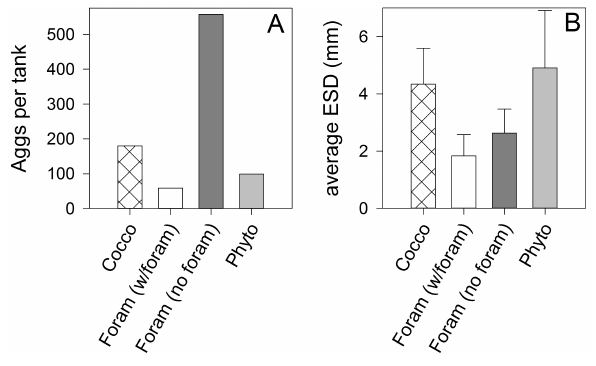
Fig. 1. Average (A) number and (B) equivalent spherical diame- ter (ESD) of the different types of aggregates formed in Tank 11 (Phyto), Tank 7 (Foram), and Tank 12 (Cocco), the three tanks from which counts are